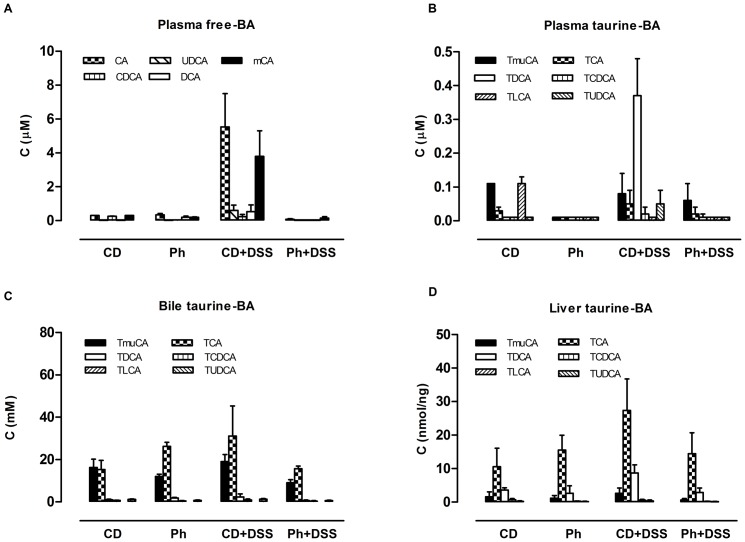
Plasma, liver and biliary BA.A. Plasma free and taurine-conjugated BA. B. Biliary BA. C. Liver BA. BA were evaluated after 14 days either Ph or CD and at the end of the study (day38). Since the CD group from day 0 to day 14 went on assuming the same usual commercial diet as before, day 14 was considered as the control value with respect to Ph. Plasma, liver and bile were collected from the same animal. The results were expressed as mean ± SD (n = 3–4 animals) CA: cholic acid; CDCA: chenodeoxycholic acid; DCA: deoxycholic acid; LCA: lithocholic acid; UDCA: ursodeoxycholic acid; muCA: muricholic acid; T-: Taurine conjugated-.